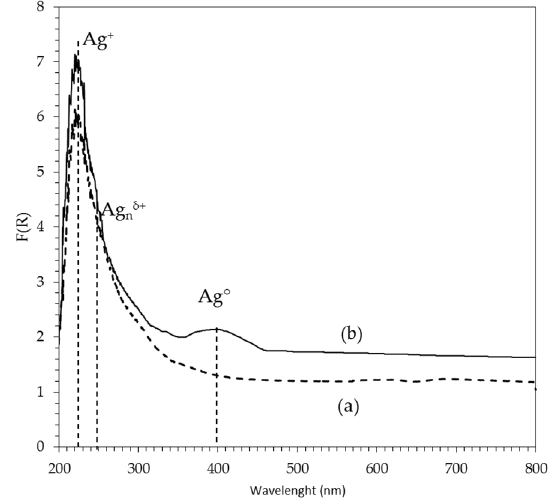
Figure 4. Ex situ UV–Vis spectra of the catalysts: ( a ) Calcined 2Ag/AW; ( b ) 2Ag/AW after H 2 reduction in a flow of H 2 (30 cm 3 /min) at 500 °C for 2 h (spectrum taken immediately after reduction in H 2 ). The absorption in the range of 240–288 nm is commonly ascribed to silver nanoclusters Ag n δ (n < 8) with a variety of cluster sizes and di ff erent oxidation states. After H 2 reduction, an absorption band at 340 and 423 nm (Figure 4b) was assigned to larger silver nanoclusters (n > 8) and metallic Ag nanoparticles